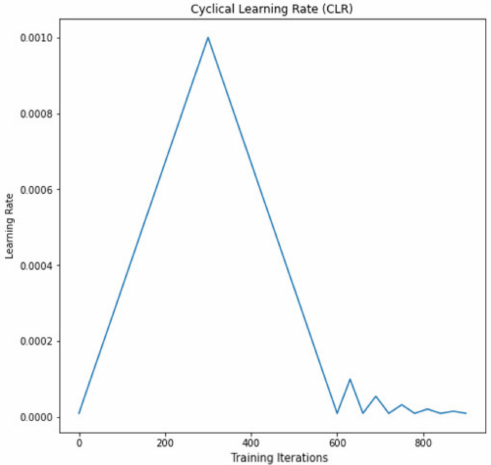
Figure 10. Schematic of the two-stage cyclic learning rate training.